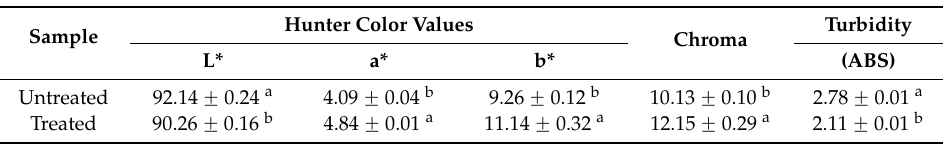
Table 2. Hunter color values (L * , a * , b * ), chroma and turbidity for untreated and alkali-treated defatted rambutan seed flours.